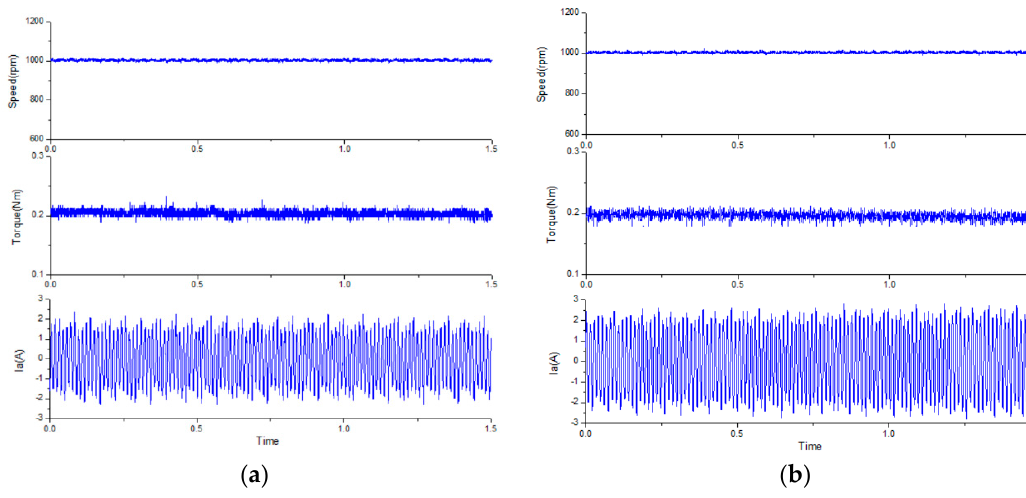
Figure 13. The steady-state response for 0.2 Nm load at a rated speed of 1000 rpm: ( a ) the traditional PI control, and ( b ) the proposed modified MPCC.